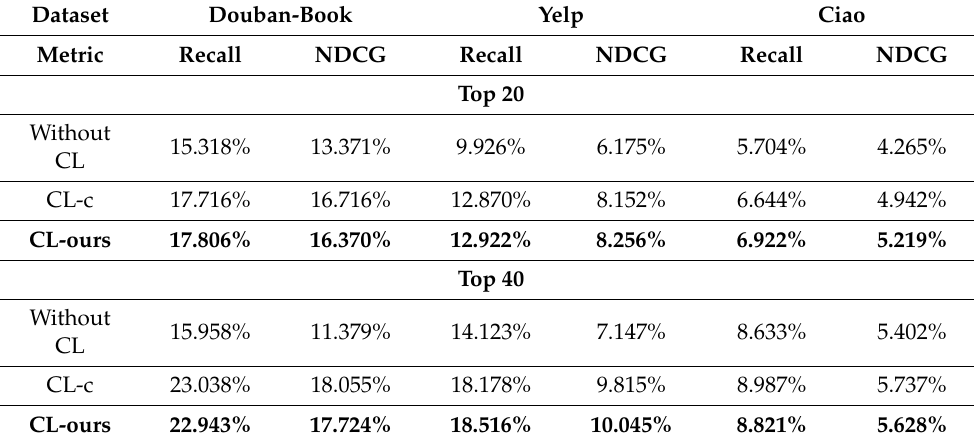
Table 5. Performance comparison of different GCLSRec